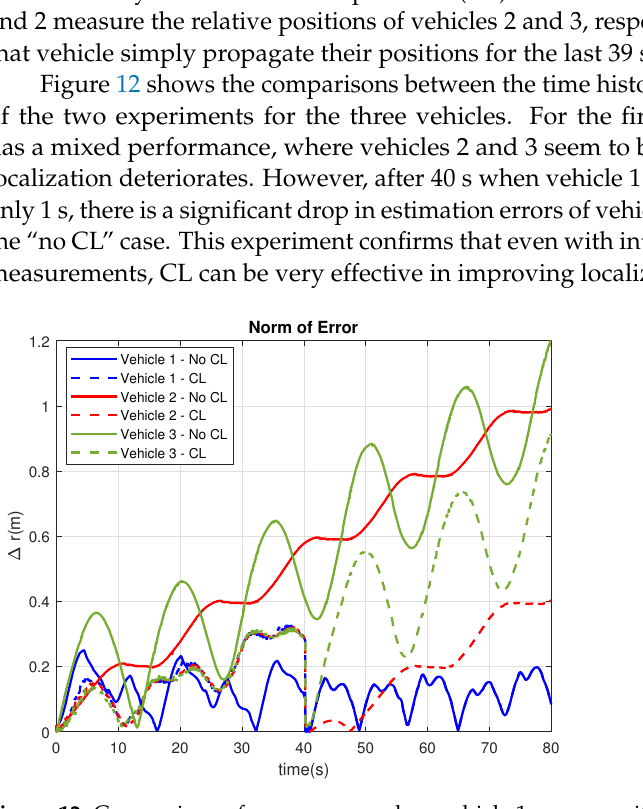
Figure 12. Comparison of error norms when vehicle 1 measures its own position for 1 s at the 40 s mark. Dashed lines indicate CL with relative position measurements for the first 40 s, and solid lines indicate no